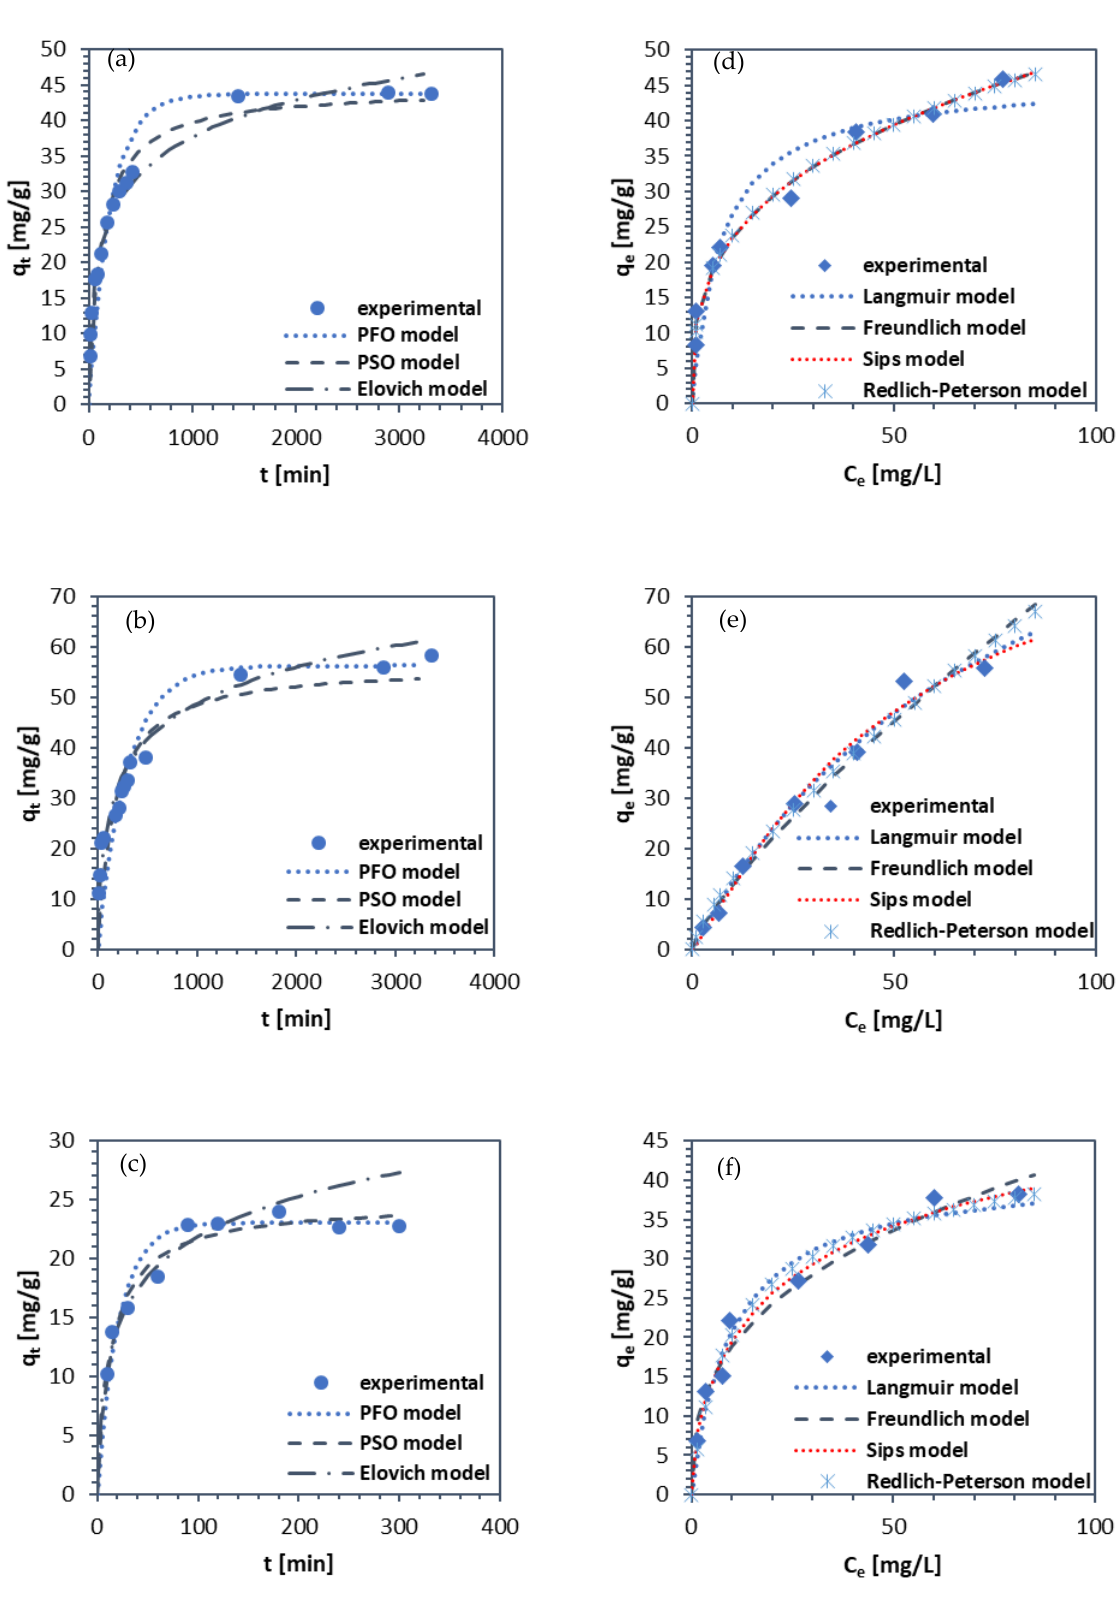
Figure 8. Adsorption of TC with experimental points and calculated fitted models: kinetic plots for